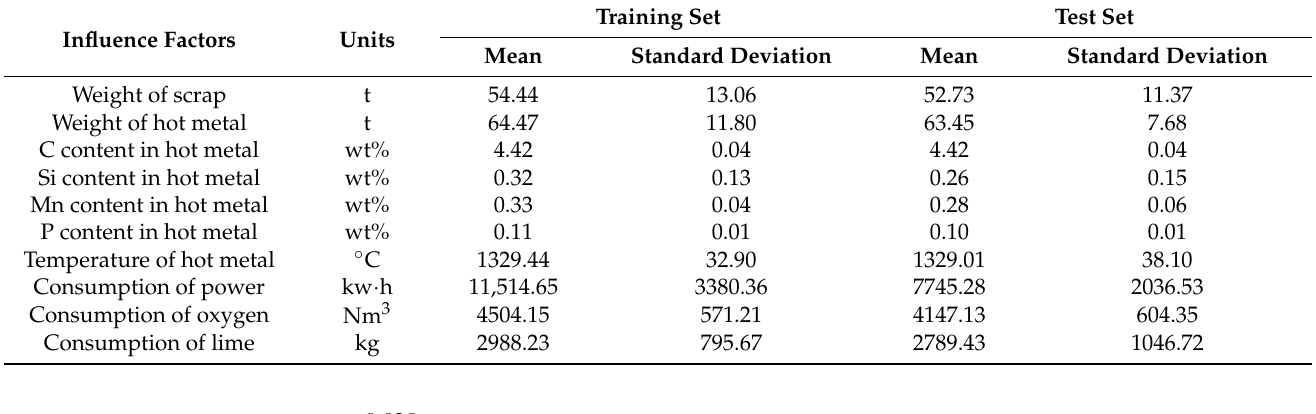
Table 3. Mean and standard deviation of input and output data.